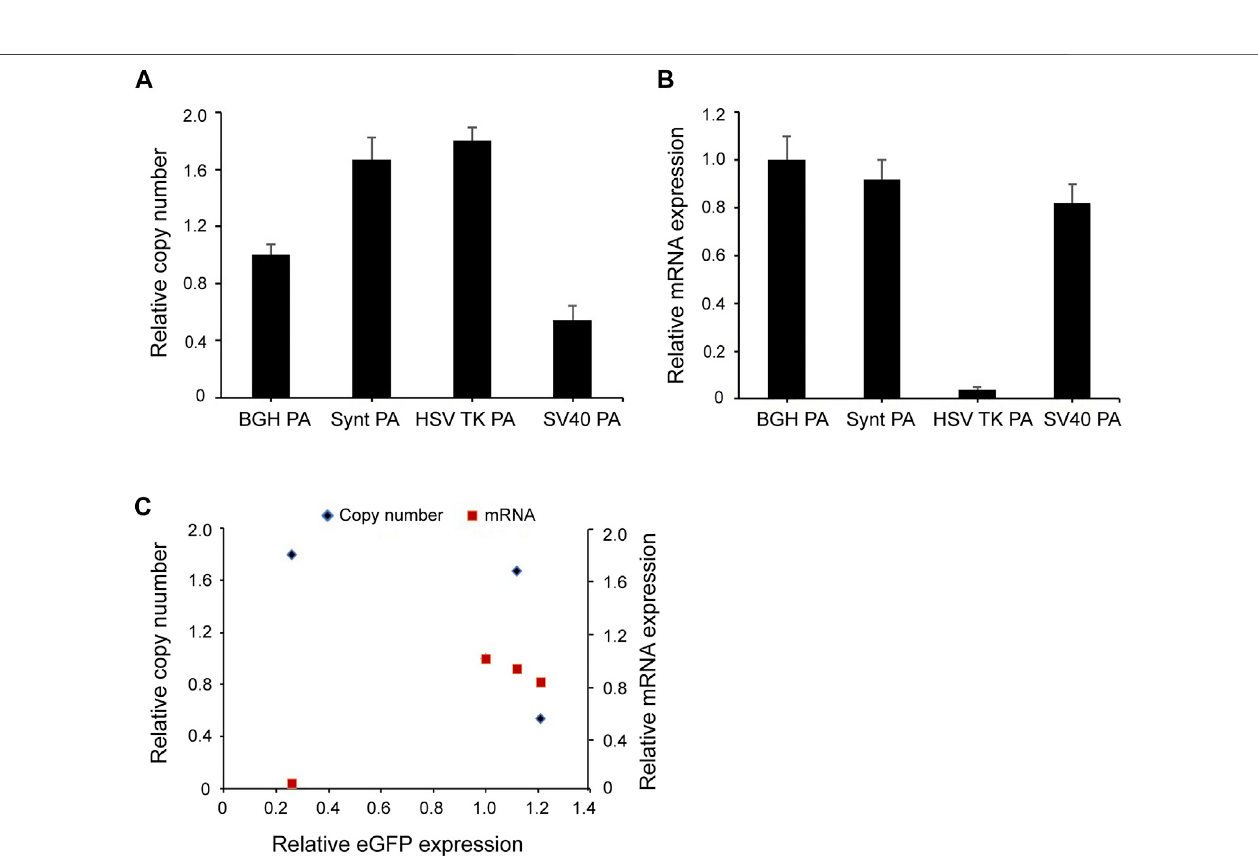
FIGURE5|(A,B) Relative eGFP copy number and mRNAexpression levelinlong-termstabletransfectedcells. Fluorescent quantitativePCRwasused toanalyze eGF PgenecopynumbersandmRNAexpression.RelativecopynumbersandmRNAexpressionlevelswerecalculatedusingthe2 − ΔΔ Ct methodandwerenormalizedto the BGH poly A vector whose value was set to 1. (C) Correlation analysis between the relative eGFP copy (blue diamond), mRNA expression (red square) and relative eGFP expression in long-term stable transfected CHO cells. Results were obtained from three independent experiments. The standard error of the mean (S.E.M.) was